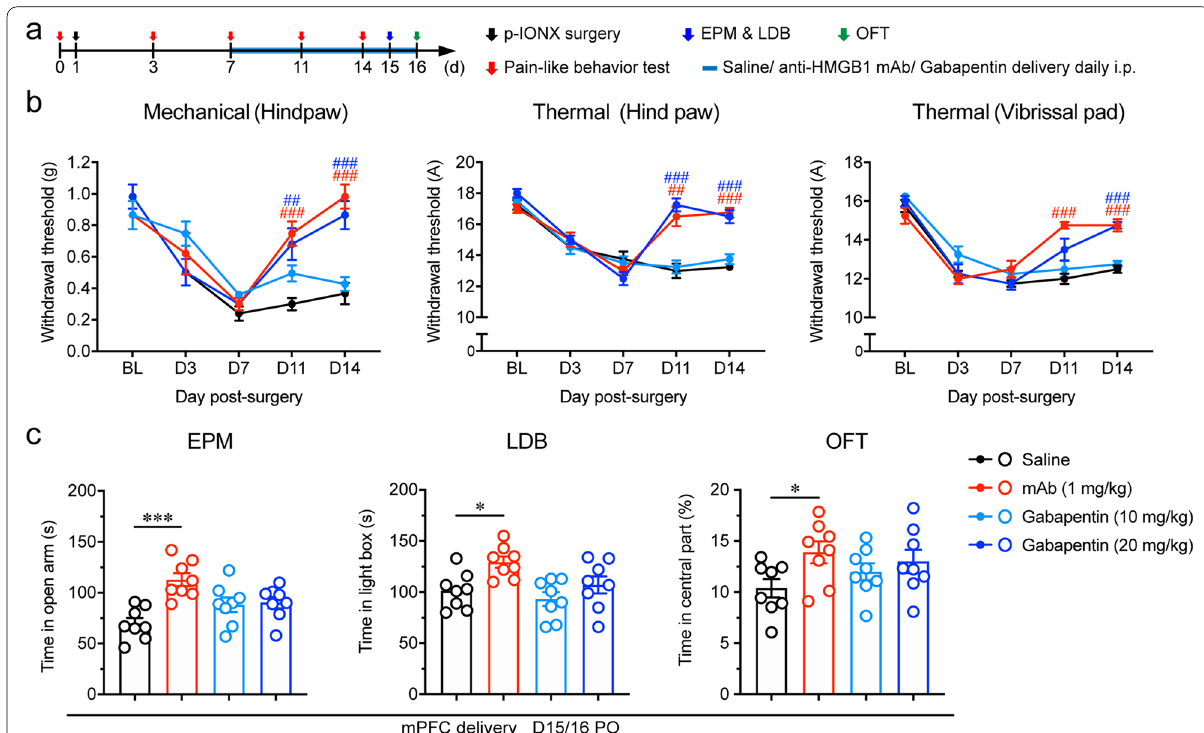
Fig. 8 Systemic anti‑HMGB1 mAb simultaneously alleviated pain sensitization and anxiety after p‑IONX. a Schedule of experimental procedures. b Paw withdrawal thresholds to mechanical stimulation and noxious heat stimulation at the left hind paw and head withdrawal threshold to noxious heat stimulation at the left vibrissal pad before and after p‑IONX. ## and ### indicate P < 0.01 and 0.001, respectively, compared with the saline‑treated group at the same time points, two‑way ANOVA with Bonferroni post hoc . c Anxiety‑like behaviors measured by EPM, LDB and OFT on D15/16 after p‑IONX. * and *** indicate P < 0.05 and 0.001, respectively, compared with the saline‑treated group, ordinary one‑way ANOVA with Dunnett post hoc . n =